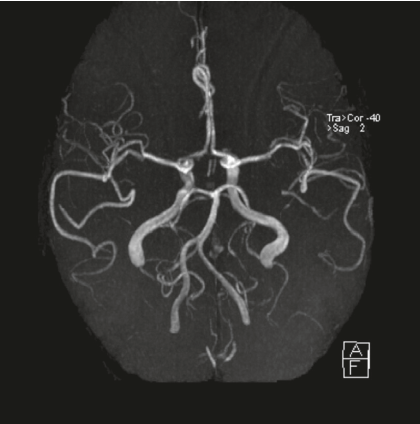
Figure 1: 3D image: brain MRA without contrast utilizing time-of-flight (TOF) technique showing normal vasculature.